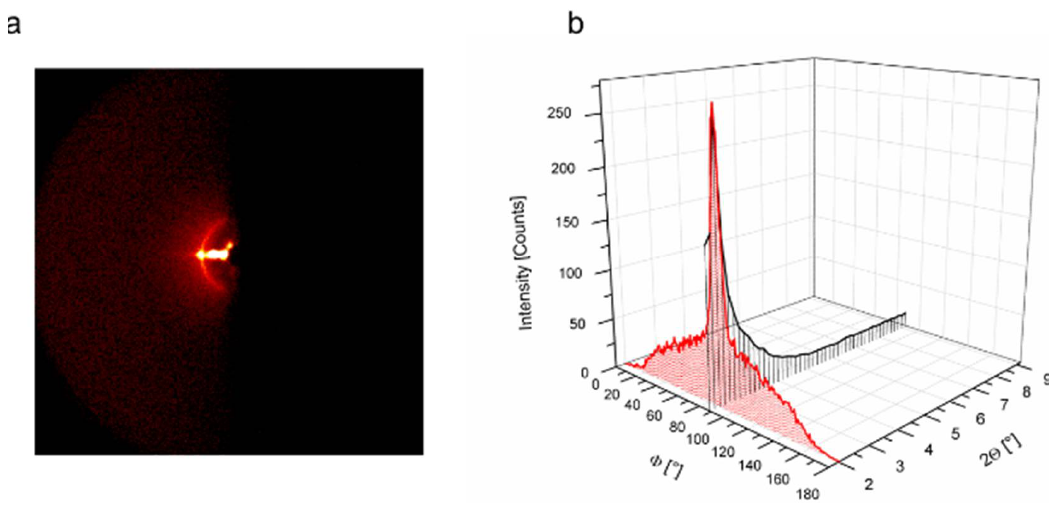
Figure 4. X-ray diffraction (XRD) results for the oriented CP36-based membrane: ( a ) Debye ring, ( b ) 2-theta and azimuthal scale.